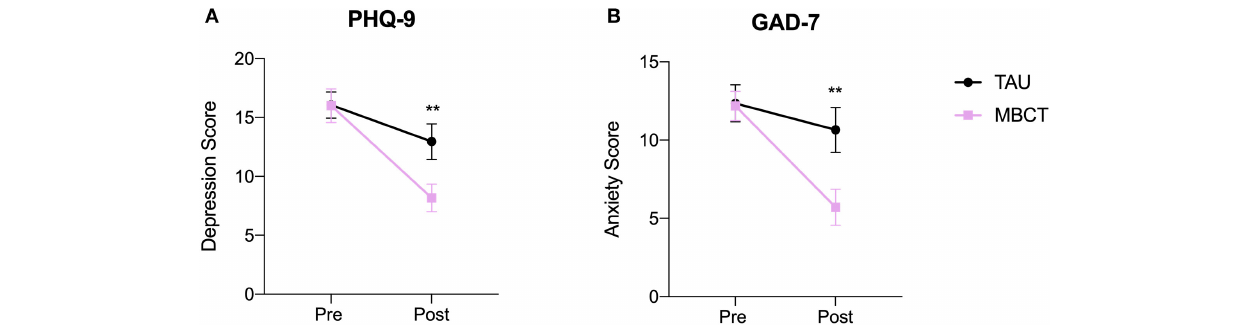
FIGURE 2 | Participants undergoing 8-week MBCT presented a significant reduction in depression (A) and anxiety (B) scores compared to TAU. ** p < 0.01, error bars: standard deviation. MBCT, Mindfulness Based Cognitive Therapy treatment group; TAU, Treatment as usual group; PHQ-9, Patient Health Questionnaire 9 items; GAD-7, General Anxiety Disorder questionnaire 7